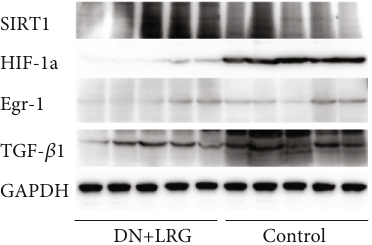
Figure 15: Western blot of SIRT1, HIF-1a, Egr-1, and TGF- β 1 protein expression in the liver. Control: diabetic nephropathy group; DN+LRG: diabetic nephropathy+liraglutide group; Egr-1: early growth response-1; HIF-1a: hypoxia-inducible factor-1 alpha; TGF- β 1: transforming growth factor- β